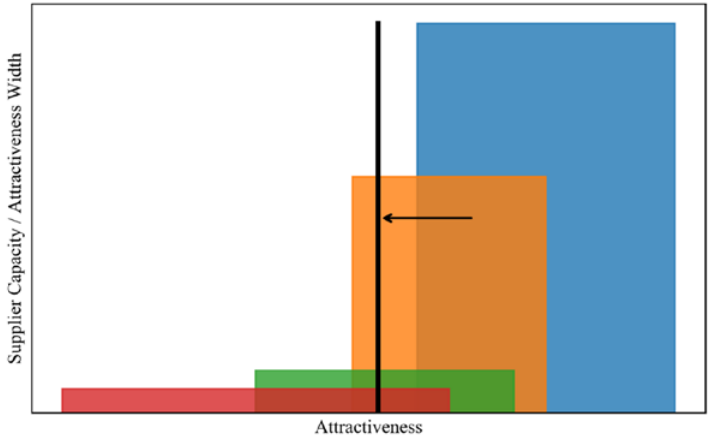
Figure 3. Illustration of Wood’s algorithm.